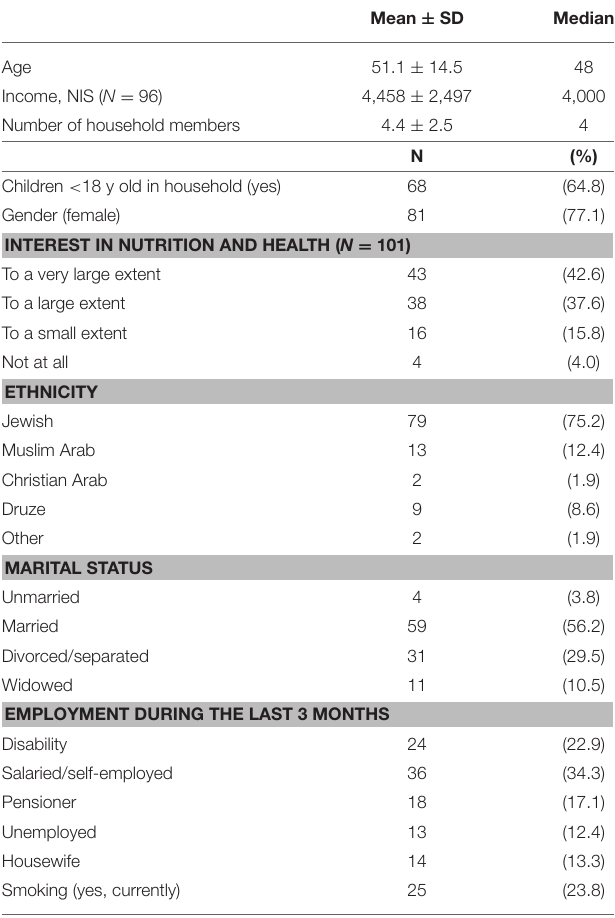
TABLE 2 | Characteristics of the aid-recipients participating in the